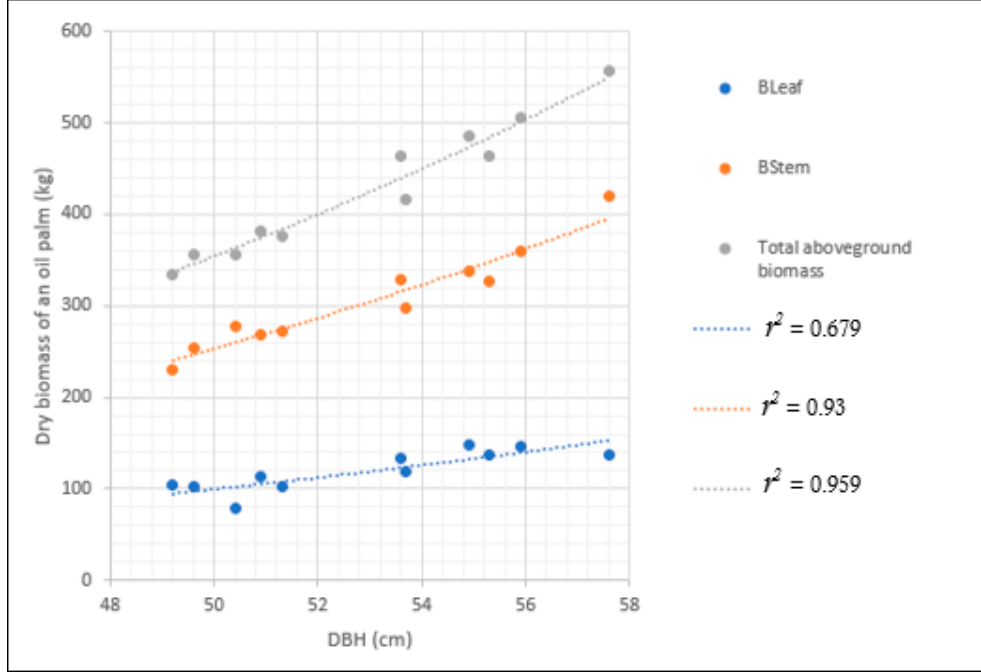
Figure 4. Allometric relationships between the biomass components of 11 oil palms and their corresponding DBH.